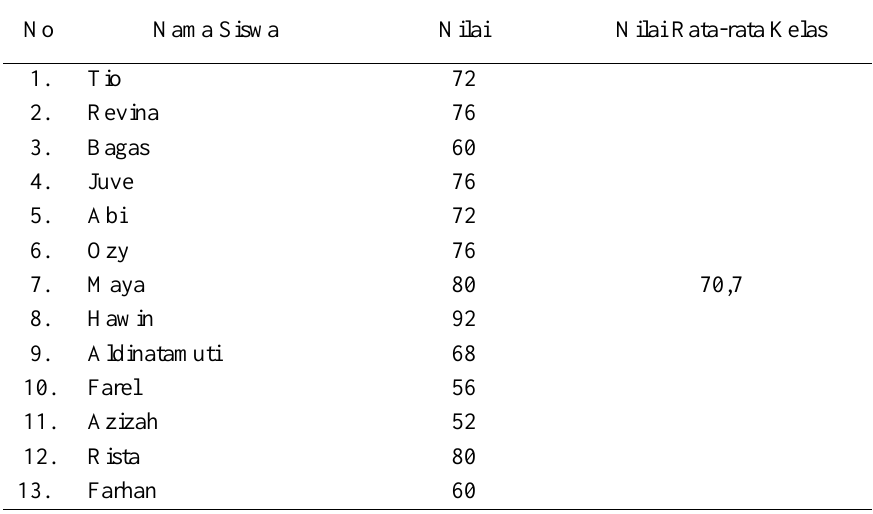
Tabel 2. Hasil Penilaian Post-Test pada Siklus